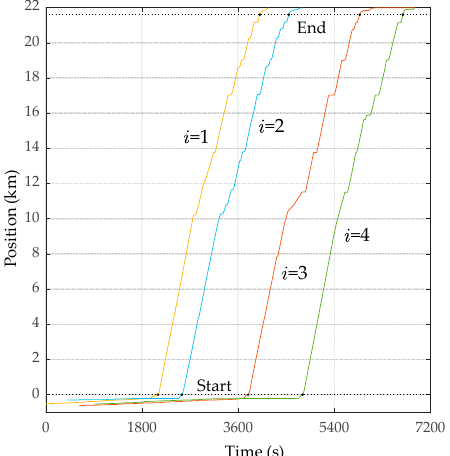
Figure 11. The x – t curve of each bus; the departure and arrival times of each bus are indicated by black dot markers. The slope of each curve represents the running speed. Note that x i ( t ) is the distance, not a coordinate.